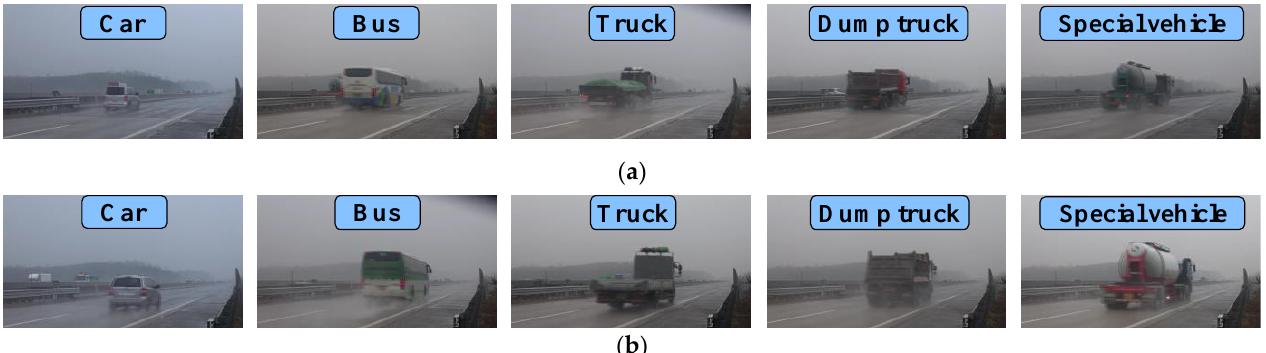
Figure 10. Representative vehicles in driving lanes in the ambient vibration test: ( a ) Representative vehicles that travelled in lane 1; ( b ) Representative vehicles that travelled in lane 2.